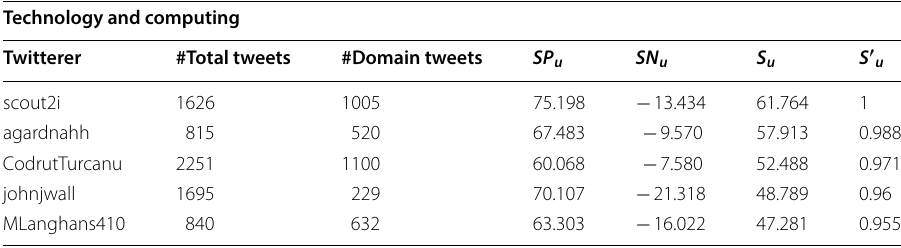
Table 5 Domain-based user sentiments replies S u ,